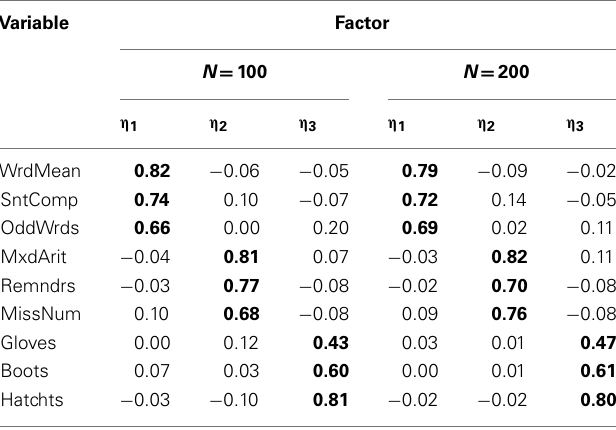
R among Case 1 item-level variables.